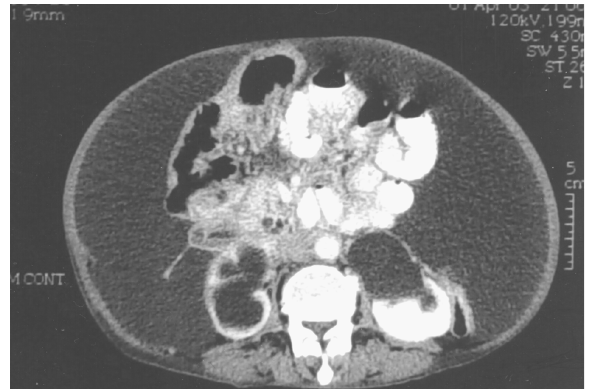
Figure 2 – Pelvic computerized tomography showing thickened bladder wall, suggesting tumoral infiltration.